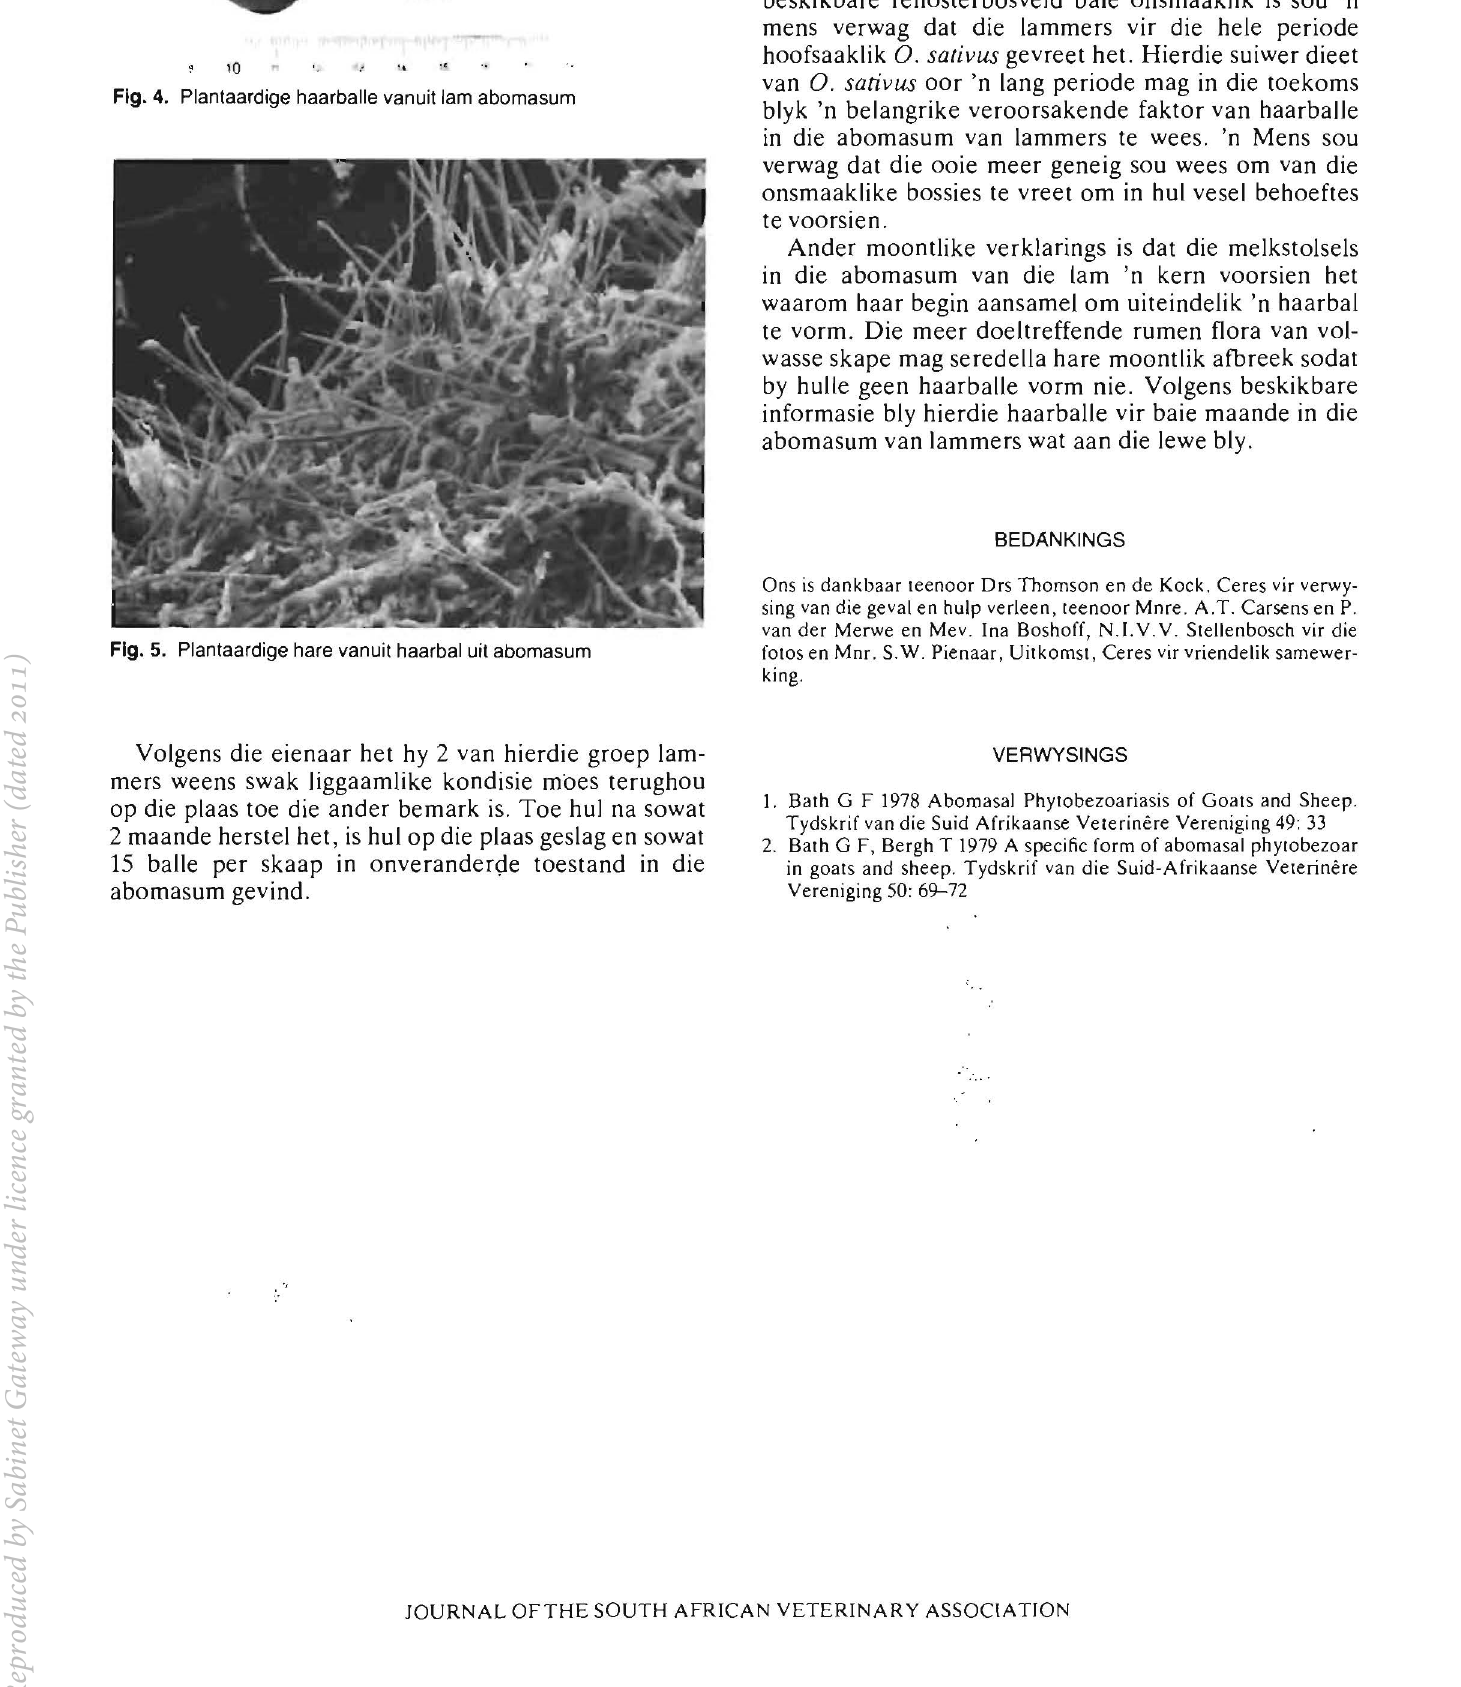
Fig. 4. Plantaardige haarballe vanuit lam abomasum